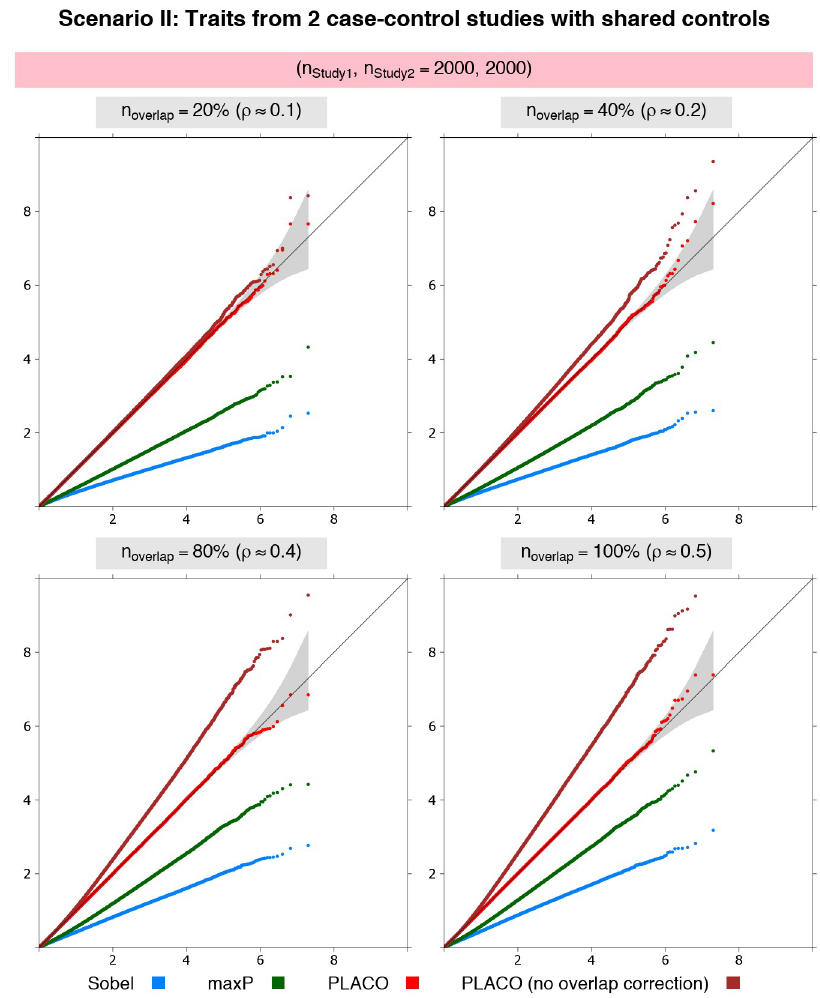
Fig 2. Scenario II: QQ plots for pleiotropic analysis of null data on traits from 2 case-control studies with different proportions of overlapping controls. Observed( − log 10 p-values) are plotted on the y-axis and Expected ( − log 10 p-values) on the x-axis. Equal study sample size, and equal case-control size assumed in each study. Each study has 1, 000 unrelated cases and 1, 000 unrelated controls, of which either 20%, 40%, 80% or 100% of the controls are shared between the two studies. Type I error performance of tests of pleiotropic effect of a genetic variant on the 2 traits is based on 9.99 million null variants with genetic effects that are either { β 1 = 0 = β 2 } or { β 1 = 0, β 2 = log(1.15)} or { β 1 = log(1.15), β 2 = 0}. The gray shaded region represents a conservative 95% confidence interval for the expected distribution of p-values. P-values � 10 -10 are shown here. within ± 500 Kb radius or in LD ( r 2 > 0.2) with our index SNP, the GWAS peak, from that